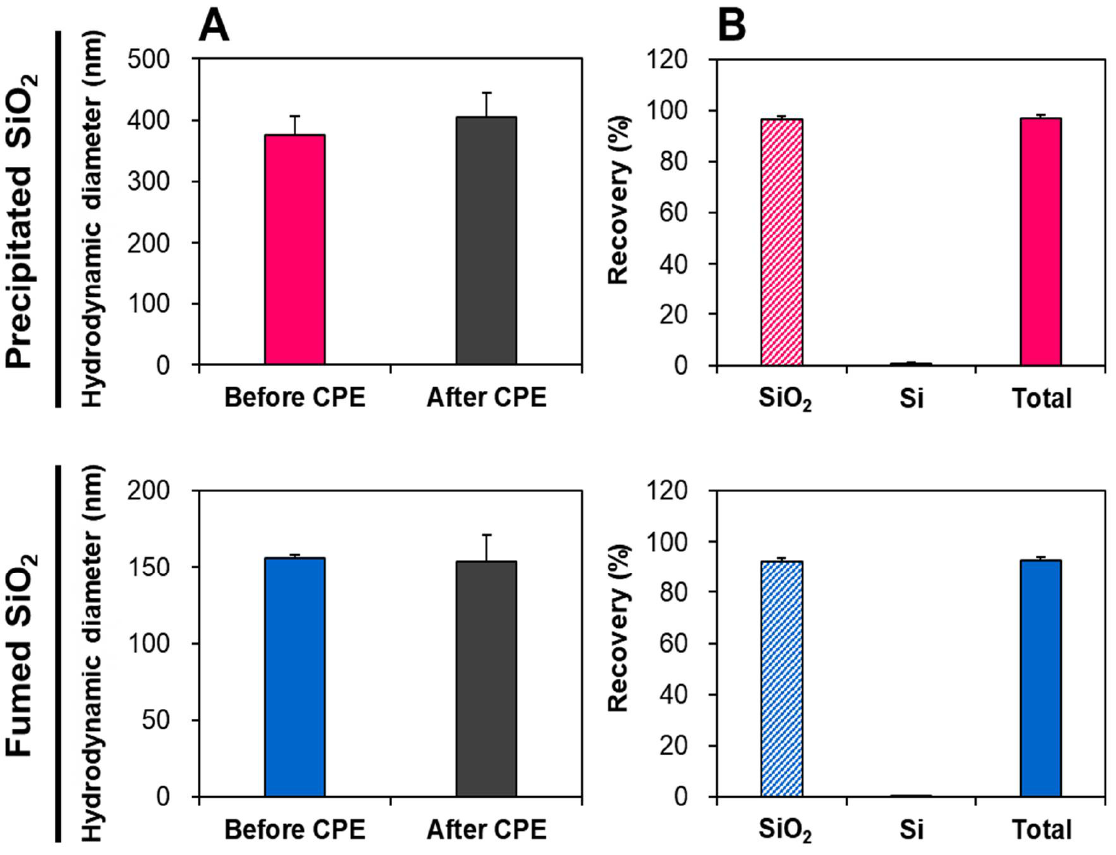
Figure 3. ( A ) Hydrodynamic diameters of food additive SiO 2 before and after cloud point extraction (CPE). ( B ) Recoveries (%) of SiO 2 particles, Si ions, and total Si levels, obtained via CPE. No significant differences between before and after CPE were found ( p > 0.05).